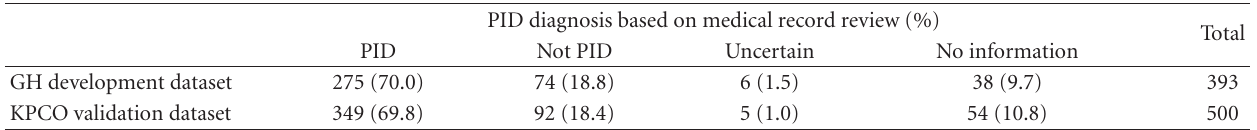
Table 2: Results from medical record reviews to assess PID cases status at Group Health Cooperative (GH) and Kaiser Permanente Colorado